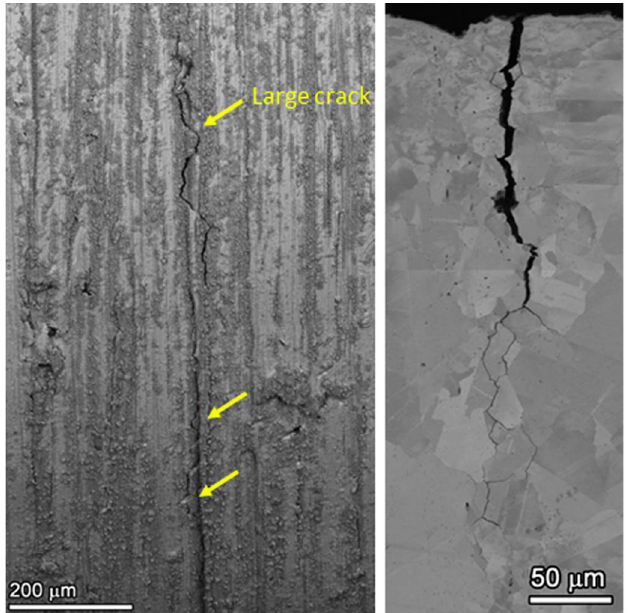
Figure 6. SEM-BSE images of Alloy 600 (as a 60-grit ground finish plate specimen), which has been exposed for 6900 h to simulated PWR water (in Ni/NiO transition conditions, and at 360 °C) and to the load at the yield strength level, showing a typical morphology of a large crack, as seen on the surface and in cross-section, reproduced from [21], with permission from Elsevier, 2020.